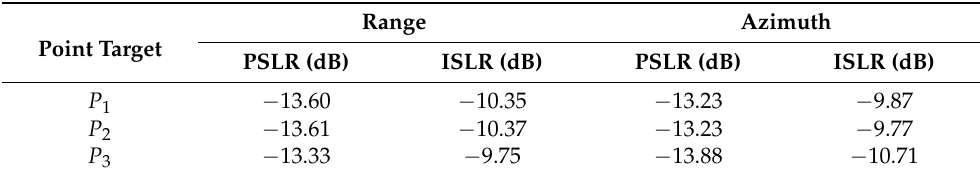
Table 3. Peak side-lobe ratio (PSLR) and integral side-lobe ratio (ISLR) of point targets.